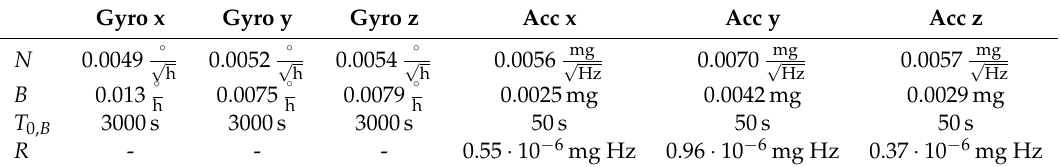
Table 1. Noise parameters identified from 48h recorded data of an IFOS-500 inertial measurement unit (IMU). Gyro x Gyro y Gyro z Acc x Acc y Acc z N 0.0049 ◦ √ 0.0052 ◦ √ h h B 0.013 ◦